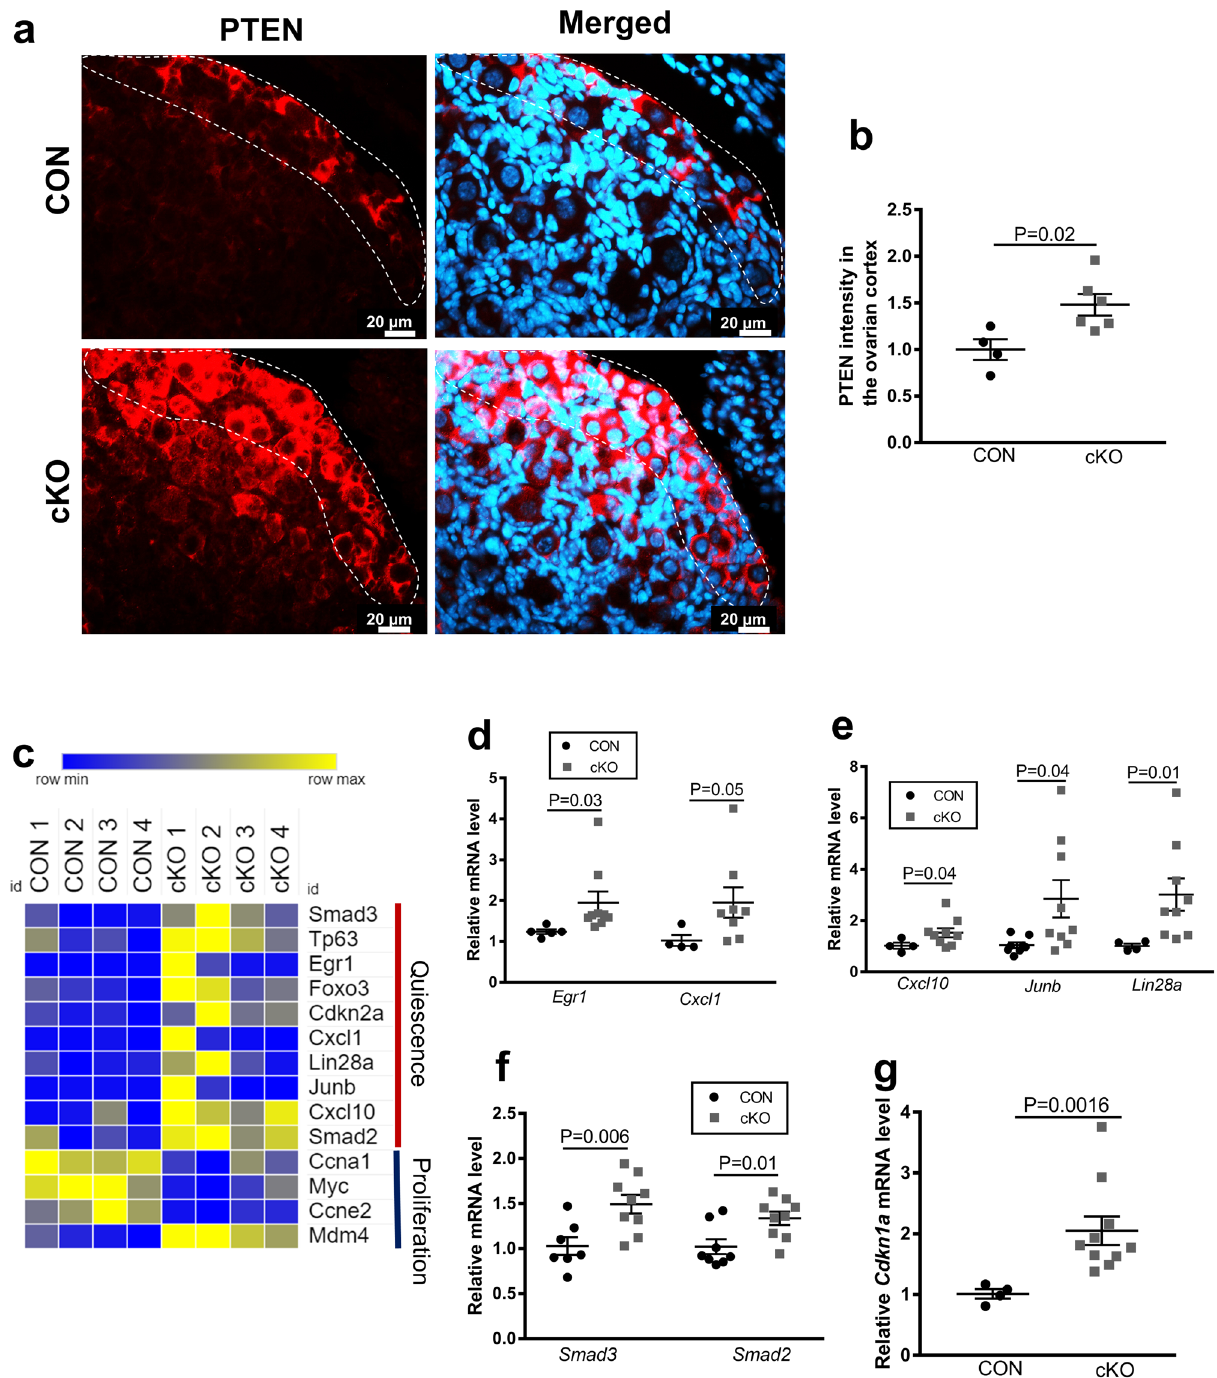
Figure 5. NR5A2 depletion affects follicle activation-related and quiescence pathways. ( a ) Immunolocalization of PTEN in CON and cKO mice ovaries at PND4. DAPI staining in right panel. ( b ) Quantitative analysis of PTEN expression between CON and cKO PND4 mice ovarian cortices (n = 4–6 animals per genotype). Quantification or protein expression was performed using CellProfiler version 4.06, www.cellp rofil er.org. ( c ) Heatmap of all differentially abundant transcripts related to quiescence and proliferation (manually selected). Blue represents a decrease, while yellow represents an increase. ( d ) Abundance of quiescence markers that changed by RNAseq (Padj < 0.05), as measured by qPCR. Markers include Cxcl1 and Egr1 transcripts in CON and cKO mice ovaries at PND4 (n = 5–10 animals per genotype). ( e ) Abundance of quiescence markers that tended to change by RNAseq ( p < 0.05), as measured by qPCR. Markers include Cxcl10 , Junb , and Lin28a transcripts in CON and cKO mice ovaries at PND4 (n = 5–10 animals per genotype). ( f ) Abundance of Smad3 and Smad2 , regulators of primordial follicle quiescence, as measured by qPCR (n = 5–10 animals per genotype). Smad3 changed by RNAseq (Padj < 0.05), while Smad2 tended to change ( p < 0.05). ( g ) Abundance of downstream marker of activation of quiescence pathways Cdkn1a , as measured by